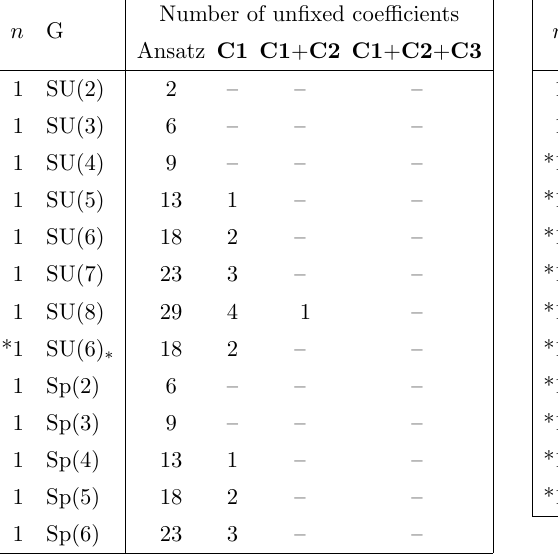
and h SO(12) b 1 2